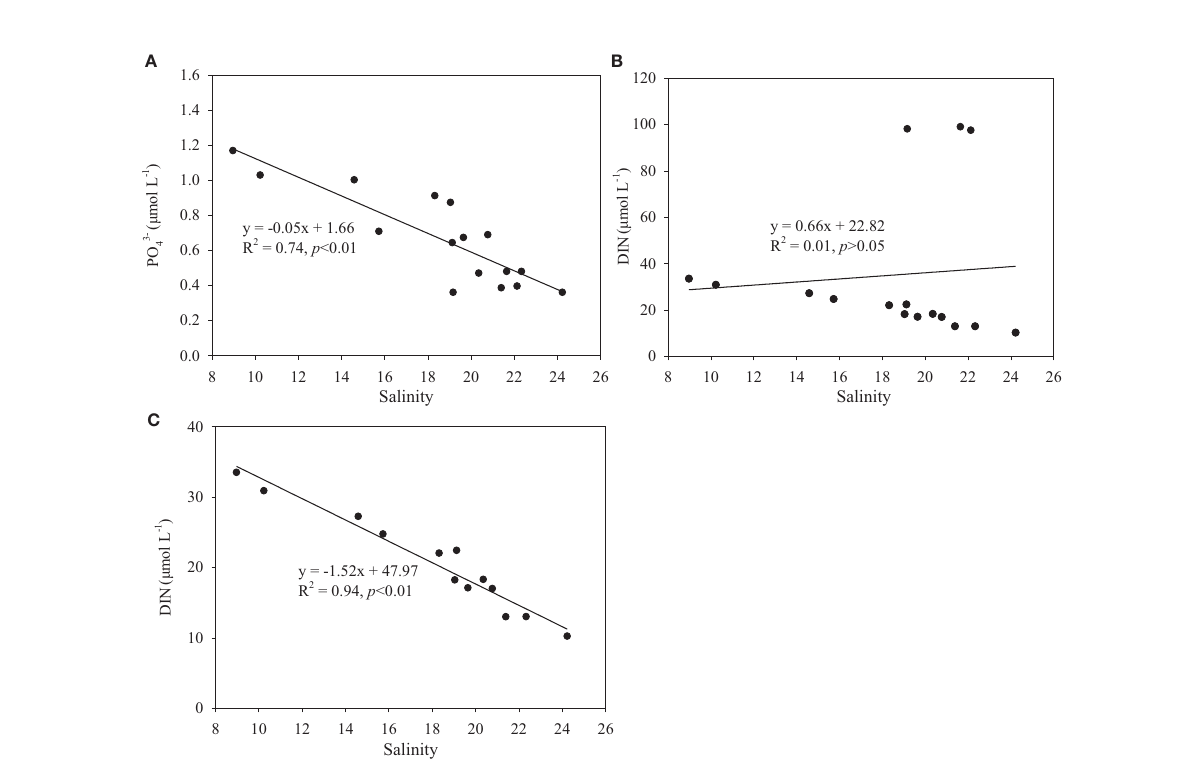
FIGURE 5 The linear relationship between PO 43- and salinity all stations of Xi Bay (A) ; the linear relationship between DIN and salinity all stations of Xi Bay (B) ; the linear relationship between DIN and salinity in Xi bay that exclude the stations in the bay mouth (C)